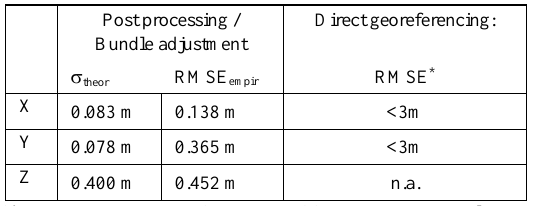
Georeferencing accuracy of 3K+ camera